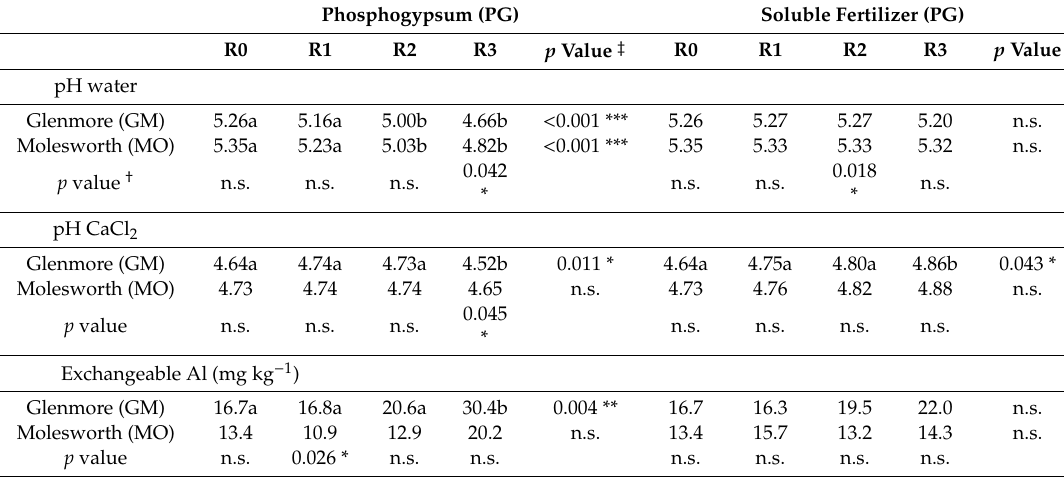
Table 5. E ff ects of phosphogypsum and soluble fertilizer on pH (water and CaCl 2 ) and exchangeable aluminum in Glenmore and Molesworth soils under liming (2 t ha − 1 ) conditions. Within rows, means followed by the same lower-case letter are not significantly di ff erent (Dunnett test at 5%, R0 = control). Within columns, means were compared using a two-sample t -test at